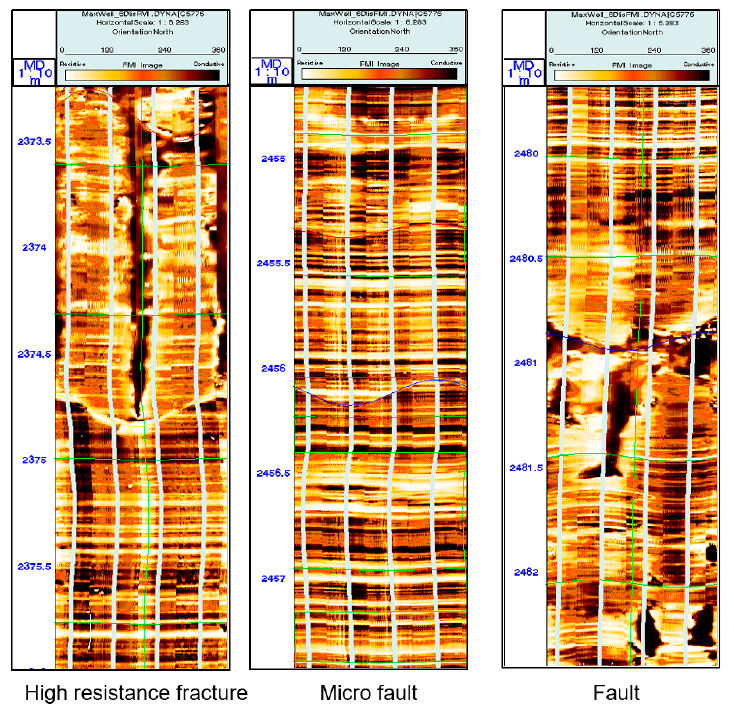
Figure 3. Characteristics of high-resistance fracture and faults of shale in east Sichuan on FMI images ( Adapted with permission from Ref. [39]. Copyright 2015, Ke Wu)